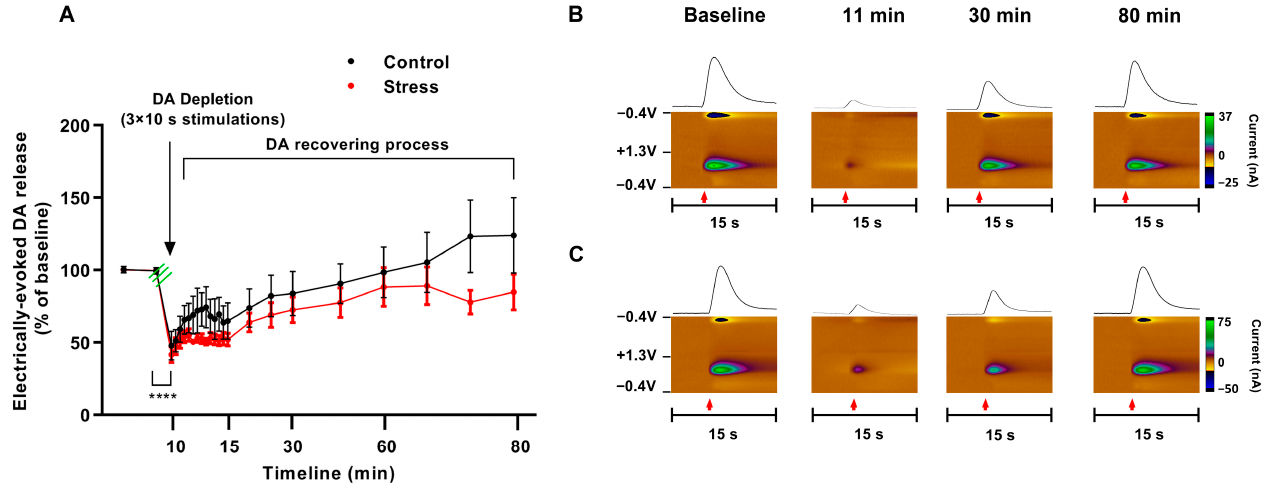
Figure 7. Social defeat stress does not affect dopamine depletion or subsequent release